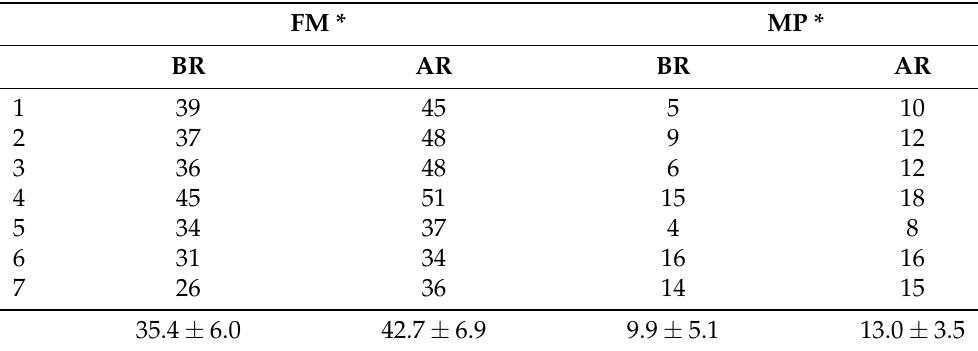
Table 2. Clinical data of patients involved in the study. BR = before rehabilitation; AR = after rehabilitation; * denotes statistical